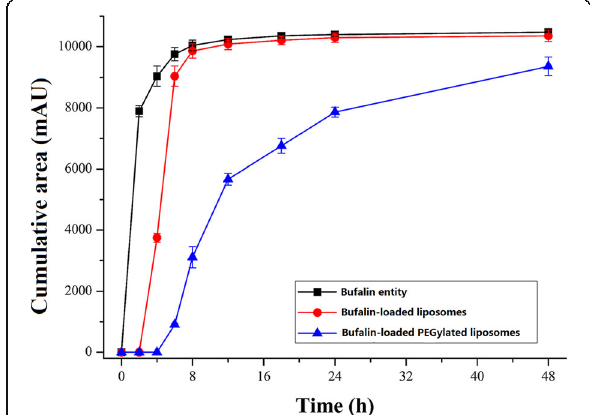
Fig. 2 In vitro release of bufalin from bufalin-loaded common